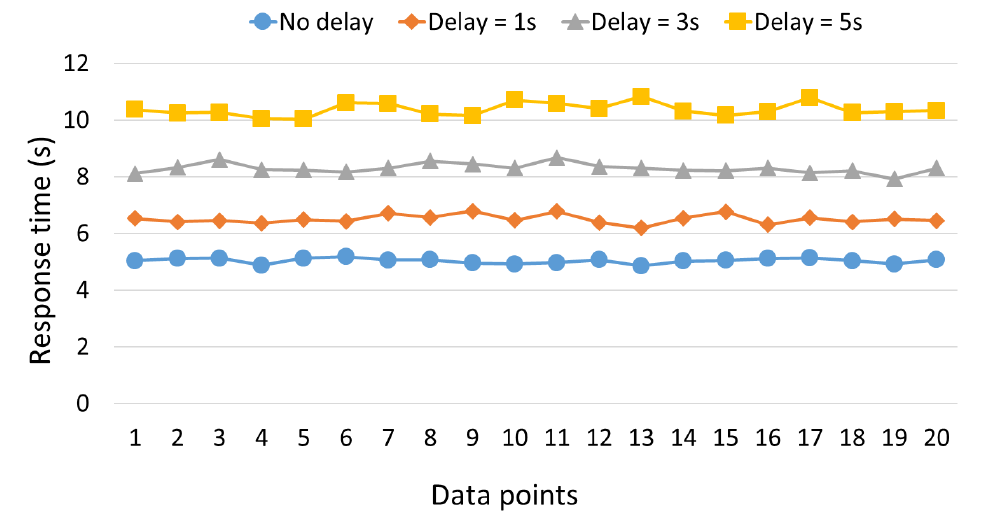
Figure 9. Time for executing a command (START, QUERY, STOP) with/ without adding delays. The CPU temperature is around 75 ◦